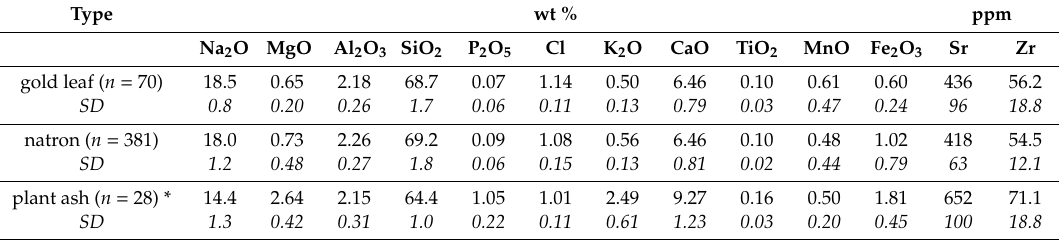
Table 1. Means and standard deviations (SD) of the gold leaf tesserae and the reduced composition of all natron-type and plant ash tesserae from